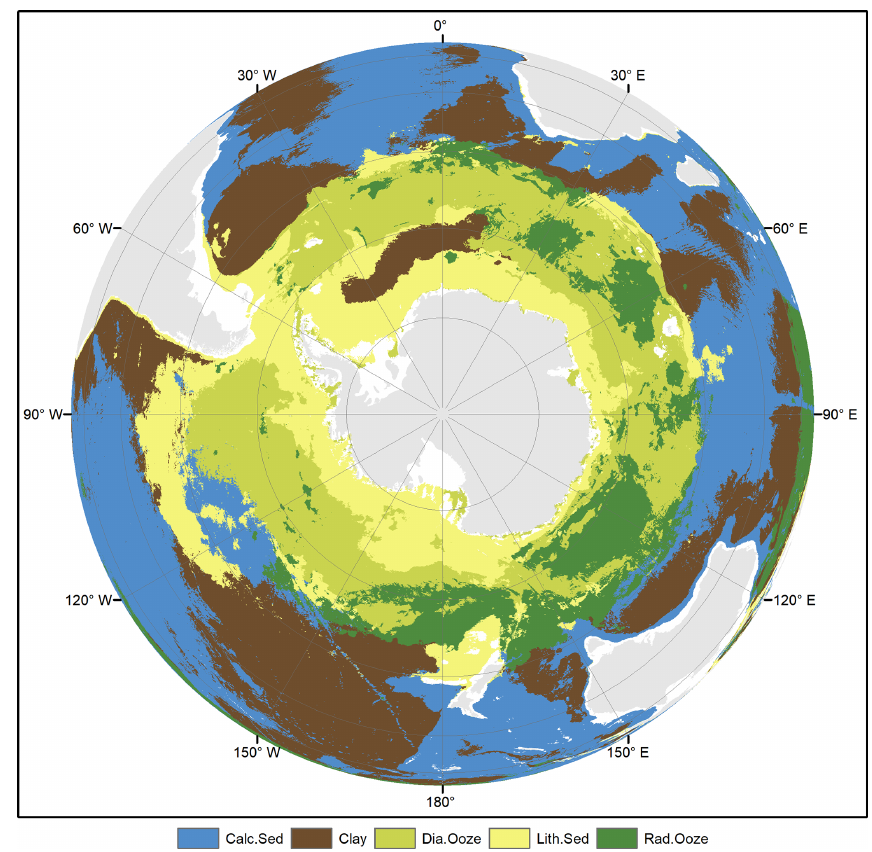
Figure A2. Predicted lithology classes in the Southern Ocean. Land masses are derived from ESRI